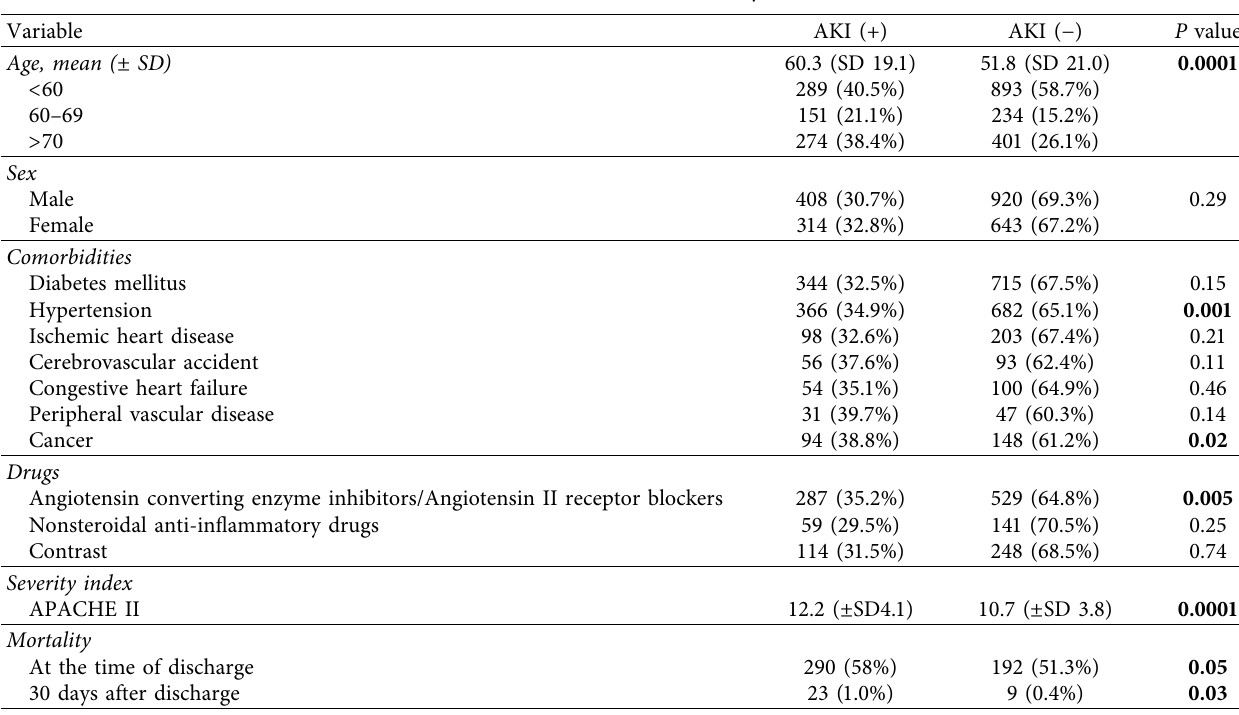
Figure 2: Boxplot graph for eGFR by AKI status. Table 3: Baseline characteristics by